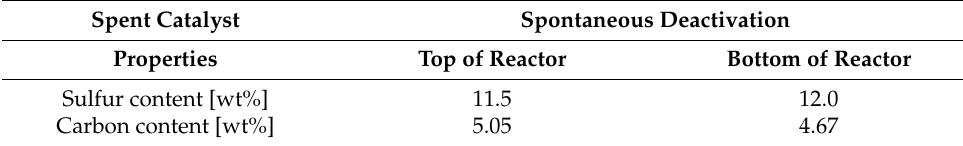
Figure 18. Differential scanning calorimetry of average sample prior to deactivation and three sam- ples after accelerated and spontaneous deactivations. Table 6. Comparison of the results of the spent catalyst for the blank test.